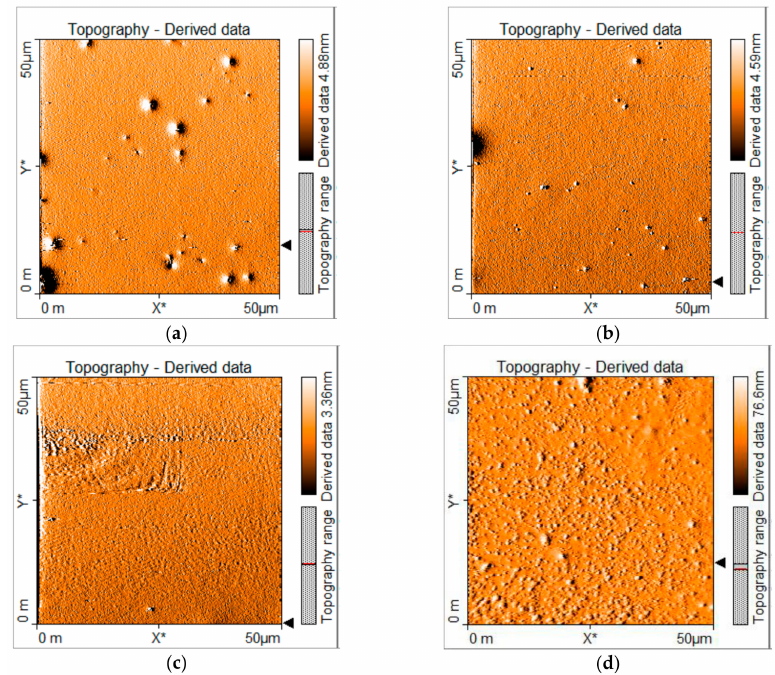
Figure 8. AFM images of deposited layers by spin coating of ( a ) CZ-2, ( b ) CZ-1, ( c ) MOC-1 and ( d ) MOC-16 molecules. ITO/PEDOT:PSS/EML architecture, as in our OLED devices, was used for these AFM